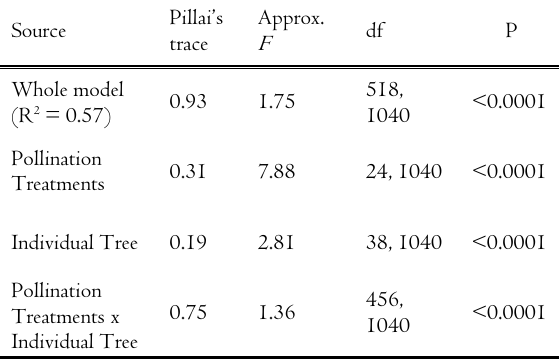
Table 1. Results for the multivariate analysis of variance (MANOVA) for the whole model, for pollination treatments, for individual trees of Goetzea elegans , and for the interaction between pollination treatments and individual